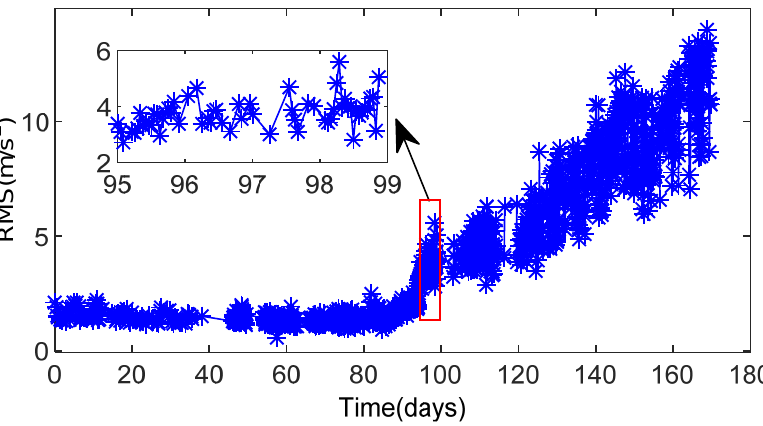
Figure 3. The variation of the RMS value.